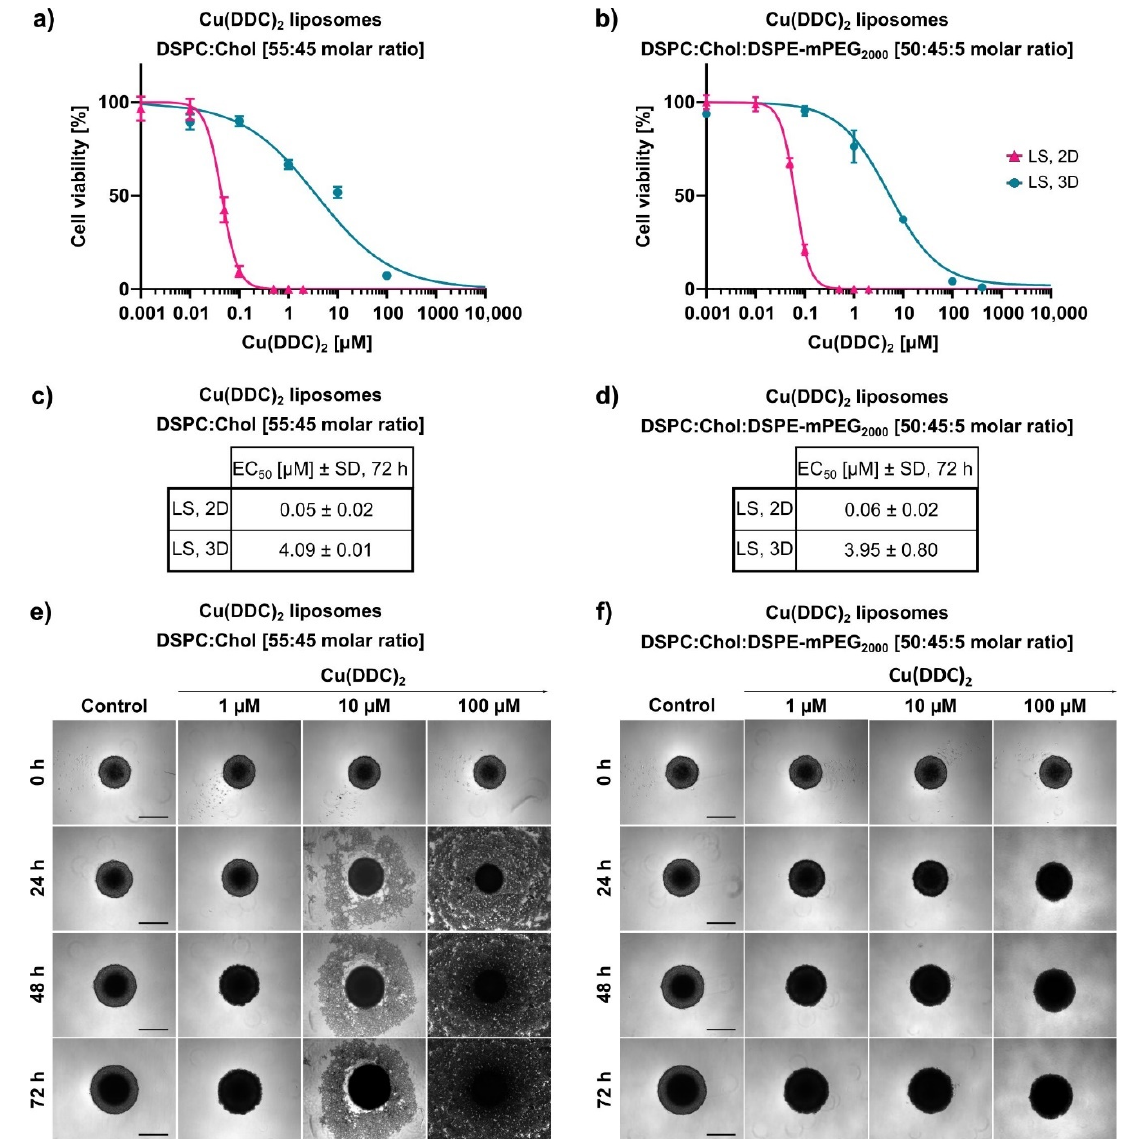
Figure 8. In vitro cytotoxicity of Cu(DDC) 2 liposomes on neuroblastoma 2D and 3D cell cultures. ( a , b ) LS monolayers (2D) and LS monoculture spheroids (3D) were treated 72 h with non-PEGylated ( a ) and PEGylated ( b ) Cu(DDC) 2 liposomes. 3D spheroids were generated by using agarose-coated wells with subsequent centrifugation. Cell viability curves were obtained using 2D and 3D CellTiter-Glo ® assay, respectively after indicated treatment duration. Data are expressed as the mean ± SD (LS, 2D: n = 7; LS, 3D: n = 5). ( c , d ) EC 50 values after 72 h of treatment with non-PEGylated ( c ) and PEGylated ( d ) Cu(DDC) 2 liposomes. Data are expressed as the mean ± SD ( n = 5–7). ( e , f ) Representative brightfield microscopy images of LS monoculture spheroids. Images were taken after 24, 48, and 72 h of treatment with non-PEGylated ( e ) and PEGylated ( f ) Cu(DDC) 2 liposomes, respectively. Scale bar = 400 µm.